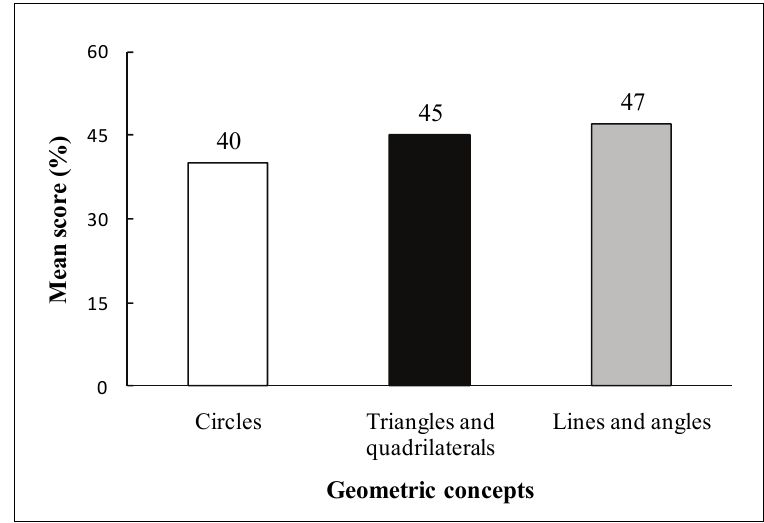
Figure 4 : Mean scores of learners in the TPGT by